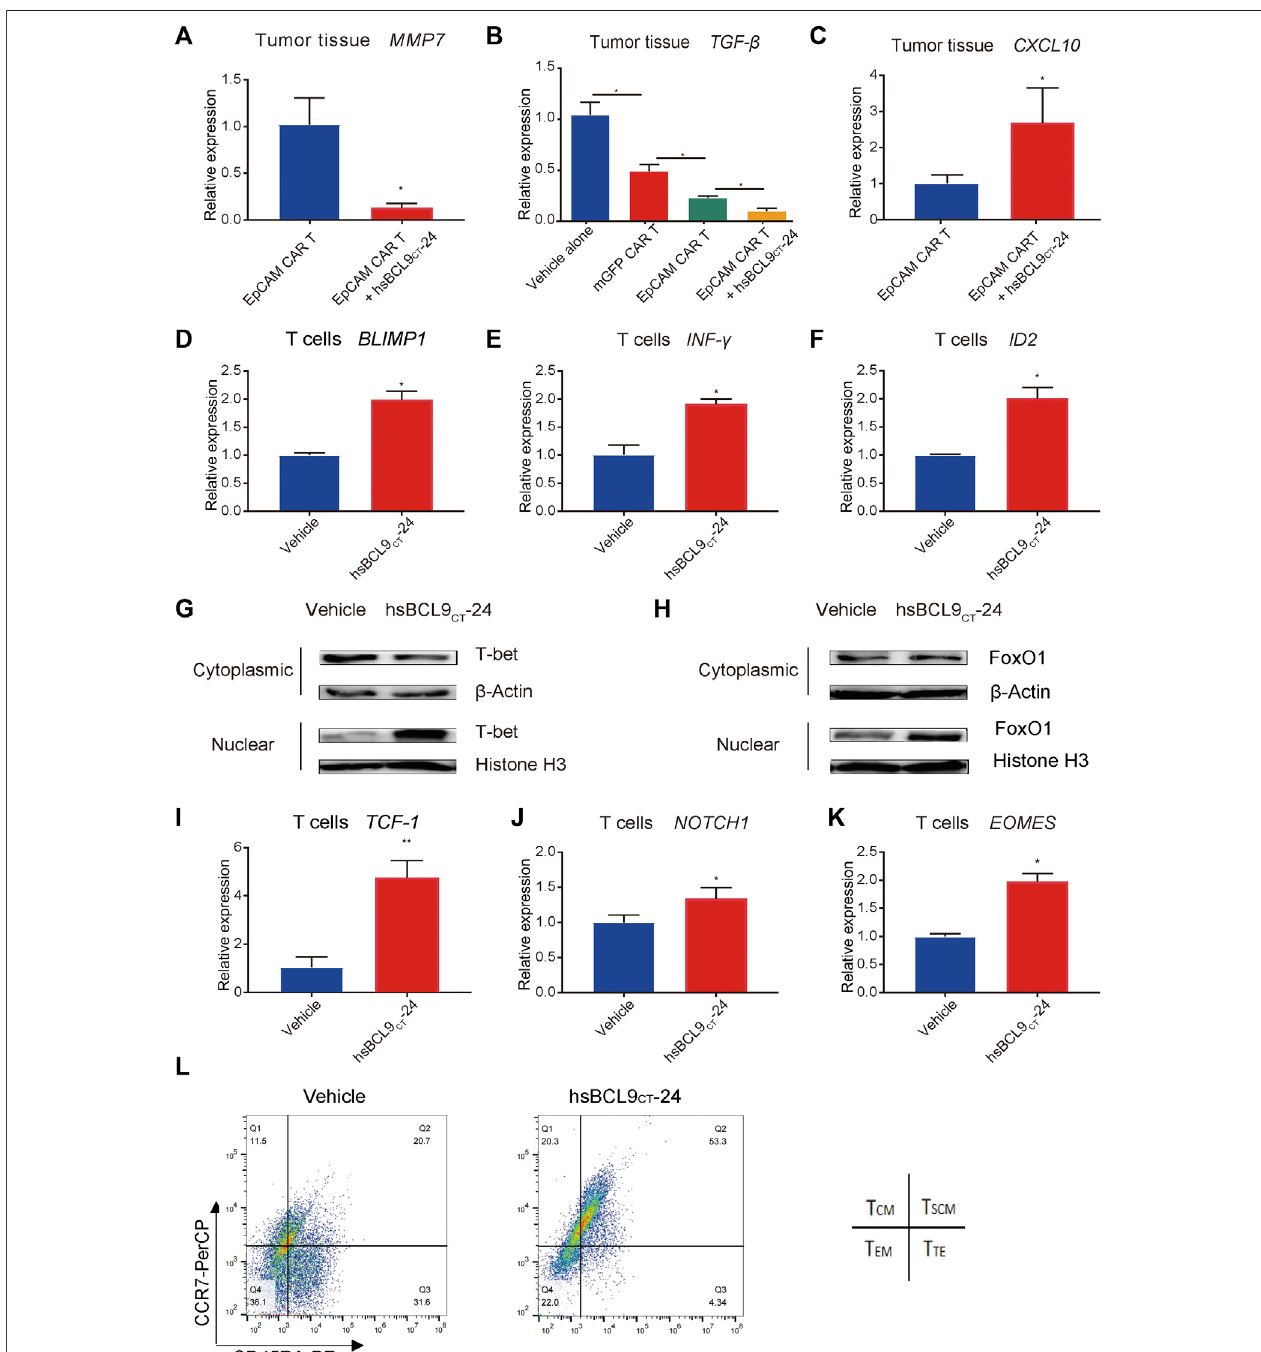
FIGURE 7 | hsBCL9 CT -24 treatment promoted molecules correlated with effector T cells and promoted the molecules correlated with early memory T cells. The total RNA of tumor tissues from mice was extracted using Trizol and qRT-PCR was performed. qRT-PCR measurement of (A) MMP7, (B) TGF- β , (C) CXCL10 expression. After24 h ofco-culture withHCT116 synergized with hsBCL9 CT -24 or vehicle, the activated Tcells werecollected. qRT-PCRmeasurement of (D) BLIMP1, (E) IFN- γ , and (F) ID2 expression in the collected T cells. (G) T-bet in the nucleus and cytoplasm was detected by western blot. The nuclear and cytoplasmic proteins were extracted using the nuclear and cytoplasmic protein extraction kit. T-bet in the nucleus and cytoplasm was analyzed with an anti-T-bet antibody. Histone H3 in the nucleus and β -actin in the cytoplasm were also detected as internal controls. (H) FoxO1 in the nucleus and cytoplasm were detected by western blot. The nuclearandcytoplasmicproteinswereextractedusingthenuclearandcytoplasmicproteinextractionkit.FoxO1inthenucleusandcytoplasmwasanalyzedwithananti- FoxO1 antibody. Histone H3 in the nucleus and β -actin in the cytoplasm were also detected as internal controls. Over 48 h of co-culture with HCT116 synergized with